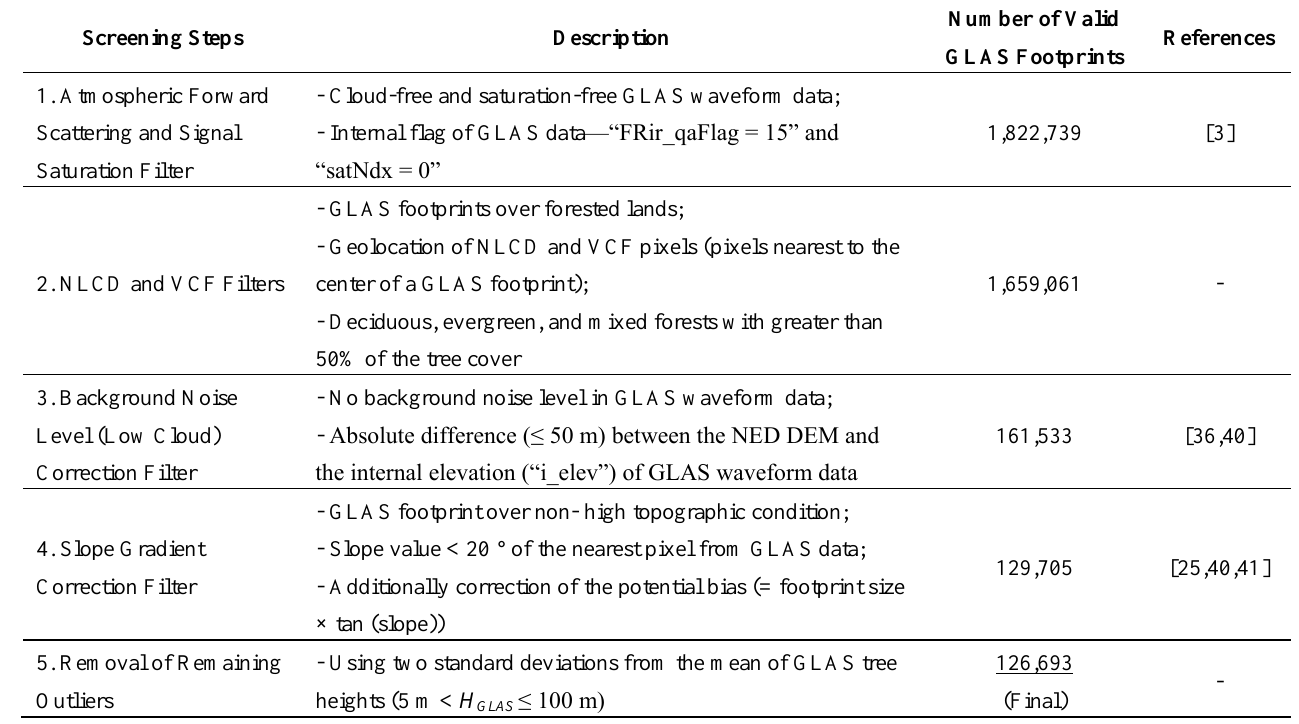
Table 3. Five screening steps to remove invalid Geoscience Laser Altimeter System (GLAS) footprints over the CONUS. Final valid GLAS footprints are 126693 in this